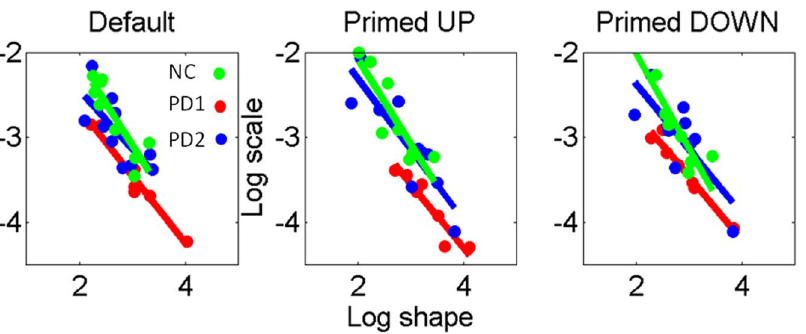
Figure 11. Individual stochastic signatures of variability for the retracting speed maxima in NC vs . patient types. Notice the changes in slope and intercept with changes in the cognitive load induced by the priming. Primed UP separates patients in PD1 maximally from the NC and from most of the patients in PD2. Primed DOWN shifts the stochastic signatures of the speed maxima for all participants, (details of the linear fit in Table S3).